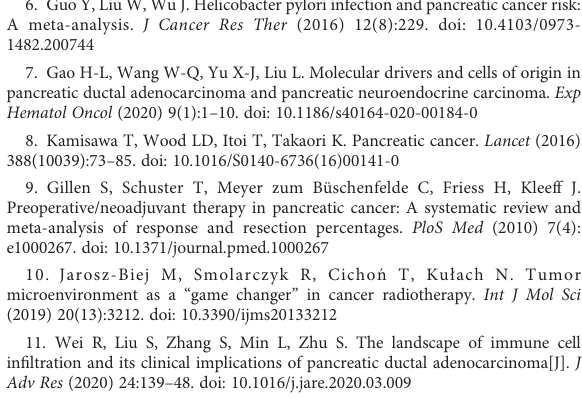
SUPPLEMENTARY FIGURE 1 Schematic illustration of the study design. SUPPLEMENTARY FIGURE 2 Volcano plots for differential expression analysis between high- and low- risk groups across the four datasets. SUPPLEMENTARY FIGURE 3 Decision-curve analysis (DCA) plot depicting the net bene fi t of adopting the risk probability as a continuous predictor for 1-, 3- and 5-year survival. SUPPLEMENTARY TABLE 1 Area under the curve (AUC) for the risk predicting the 1-, 3- and 5- year